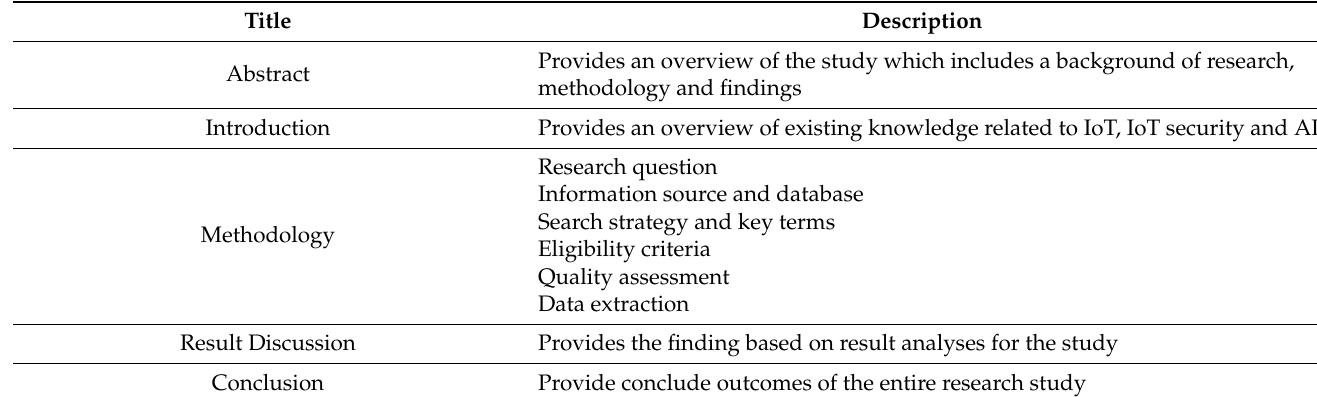
Table 2. SLR method based on PRISMA